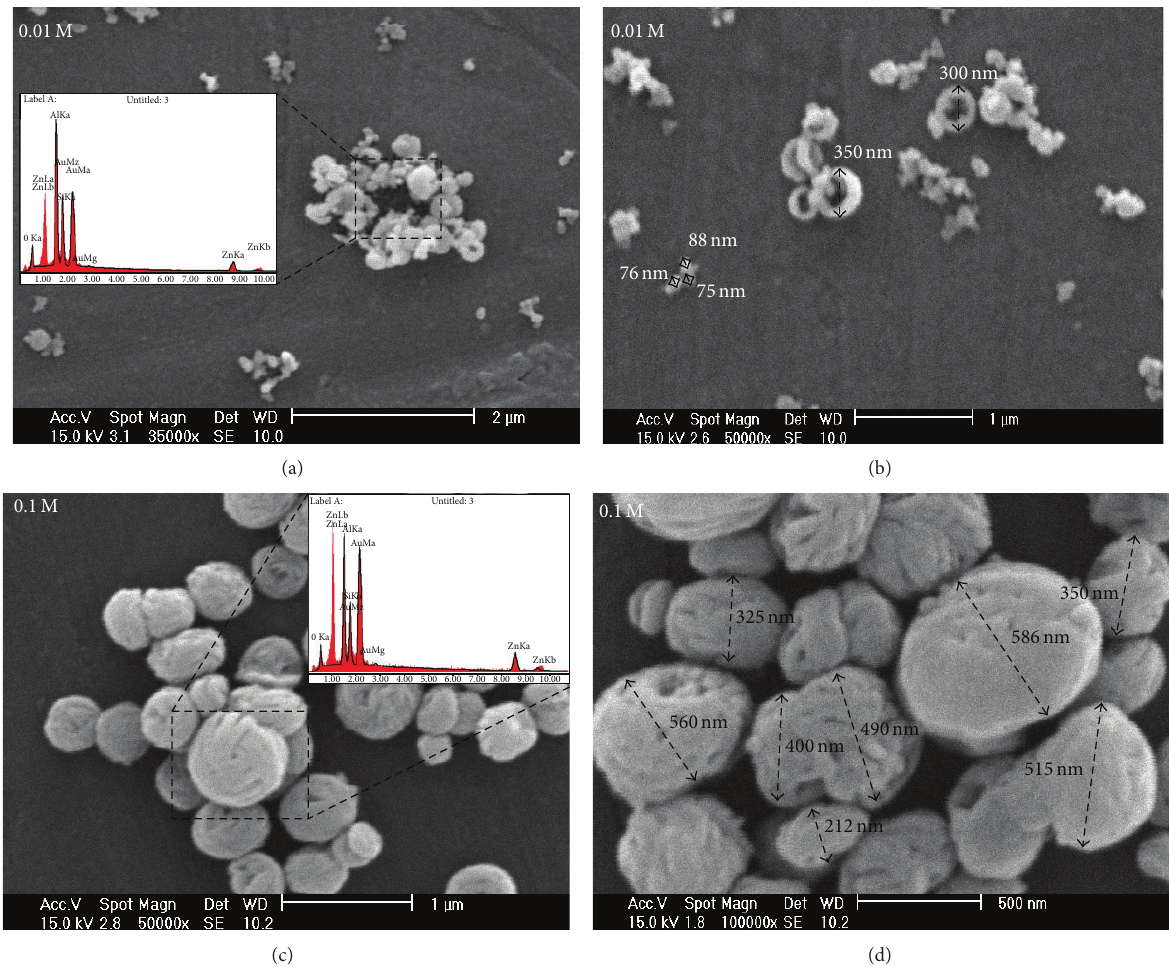
Figure 4: Low and high of magnification scanning electron micrographs of ZnO nanoparticles synthesized from the precursor solution of 0.01 M ((a)-(b)) and 0.1 M ((c)-(d)).